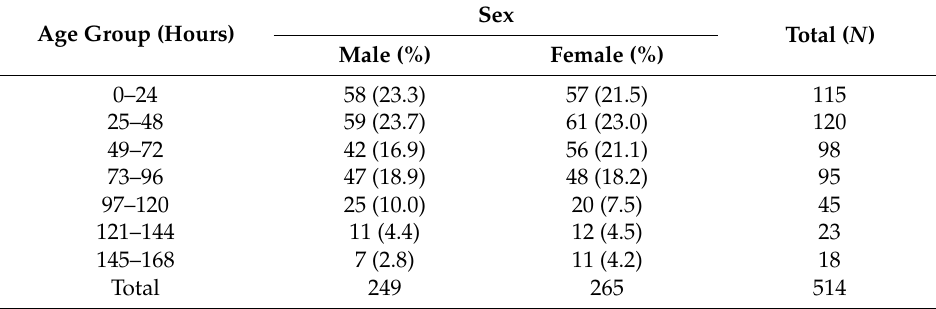
Table 1. Sex distribution of the study subjects.